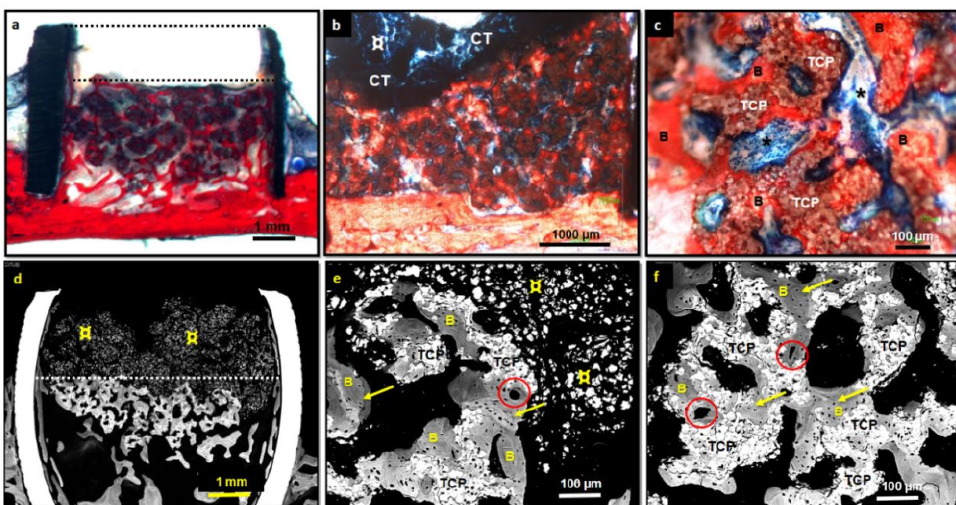
Figure 7. Histological ( a – c ) and BS-BSE images ( d – f ) of rings implanted with β -TCP granules. After implantation, 20% of the cylinder was empty (upper dotted line) ( a ). A high amount of remaining β -TCP was not osteointegrated ( b , d , e ) and vertical bone growth achieved only the middle of the cylinder height (lower dotted line) ( a , d ). Non-osteointegrated granulates were surrounded by connective tissue at the upper cylinder part ( b ). New trabecular formed bone showed homogeneous material osteointegration ( b , c , e , f ). Trabecular bone maturation was evident, with regular mineralized osteocytes lacunae and some vascular channels ( e , f ). Hematopoietic bone marrow was present ( c ). Legend: B: newly formed bone; ¤: non-osteointegrated material; * : hematopoietic bone marrow; yellow arrow: osteocytes lacunae; red circle: vascular channels; CT: connective tissue; TCP: β -TCP